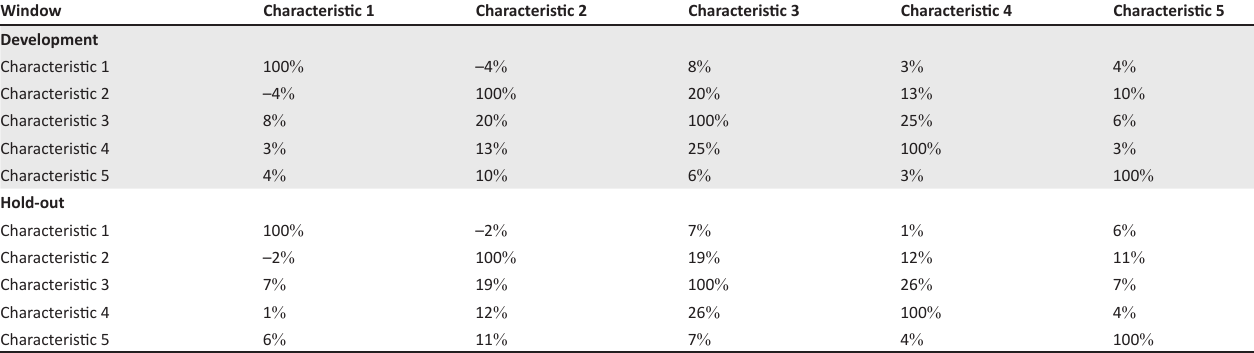
TABLE 7: Correlation